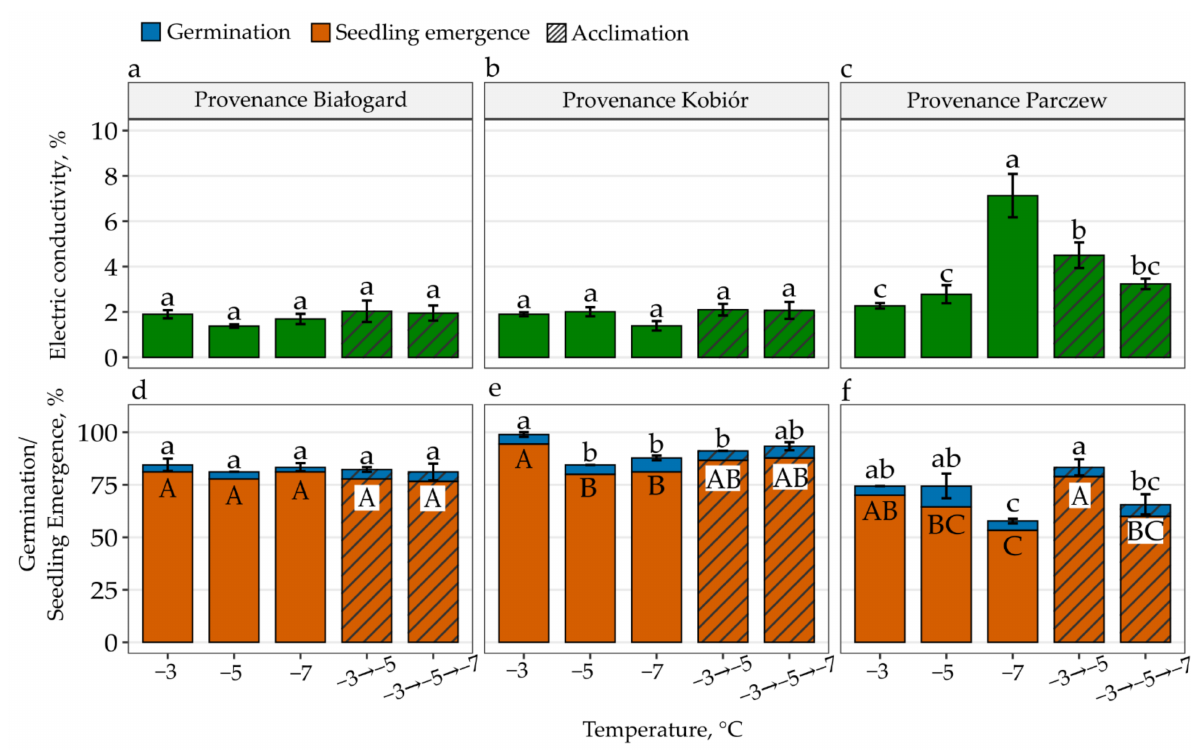
Figure 3. Seed viability determinants: ( a – c ) electric conductivity, ( d – f ) germination and seedling emergence in short- term stored pedunculate oak seeds originating from three provenances Białogard, Kobi ó r and Parczew. Data are the means of three independent replicates ± the SE. Identical letters indicate groups not significantly differentiated according to Tukey’s test.